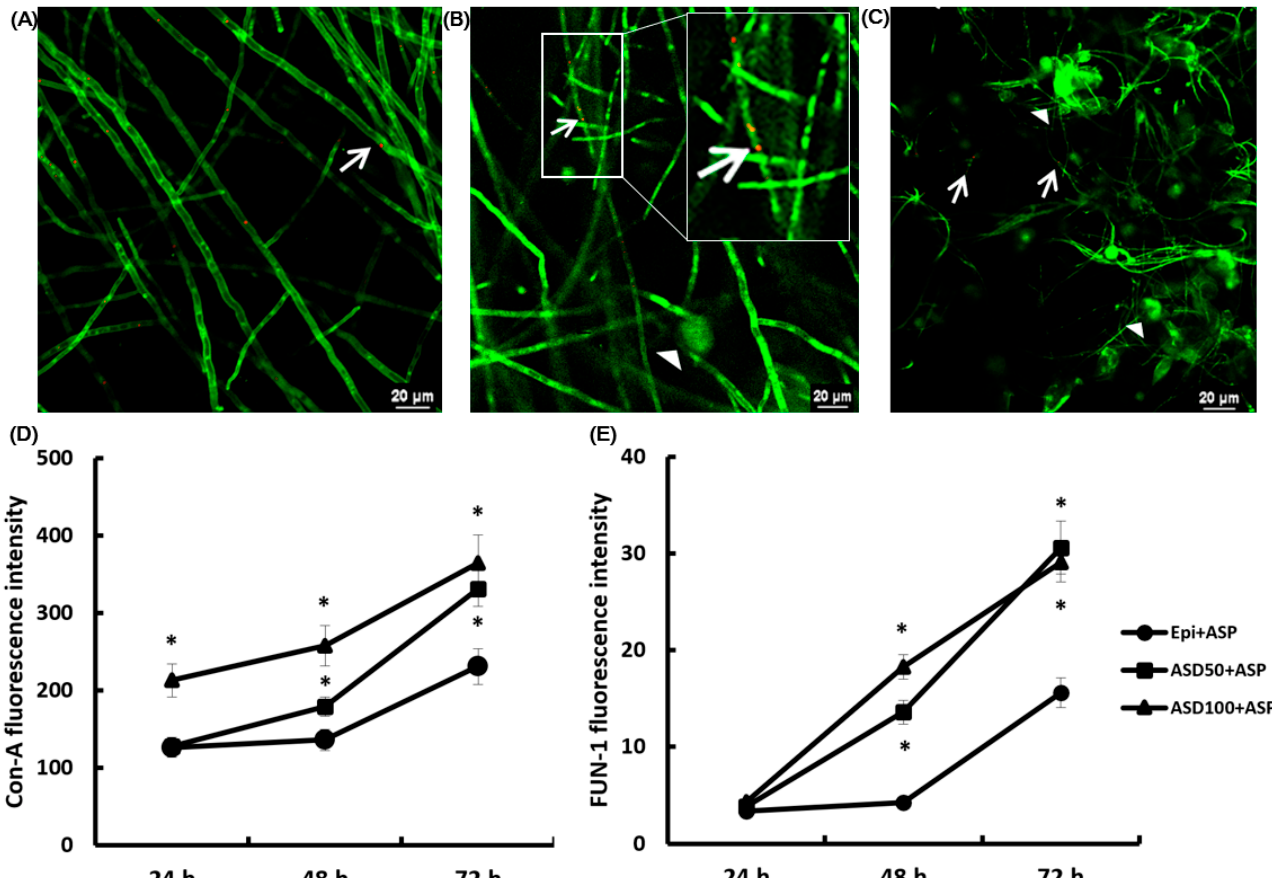
Figure 4. Confocal scanning laser microscopy findings of Aspergillus fumigatus (ASP) treated with Asian sand dust (ASD). ( A – C ) show the representative confocal scanning laser microscopic findings. A. fumigatus with nasal epithelial cells (Epi+ASP) at 24 h ( A ), 48 h ( B ), and 72 h (( C ) 60 × magnification). The arrowhead indicates concanavalin A (Con-A) stain binding at the fungal cell wall’s polysaccharide and extracellular matrix, and the arrow indicates the FUN-1 stain binding to metabolically active fungi. When ASP was incubated with primary nasal epithelial cells, the fluorescent intensity of Con-A ( D ) and FUN-1 ( E ) increased in a time-dependent manner. The coculture of ASP and 50 μ g/mL of ASD (ASD50) or 100 μ g/mL of ASD (ASD100) significantly enhanced the Con-A and FUN-1 intensity at 48 h and 72 h. *: p < 0.05 compared to Epi+ASP, k =